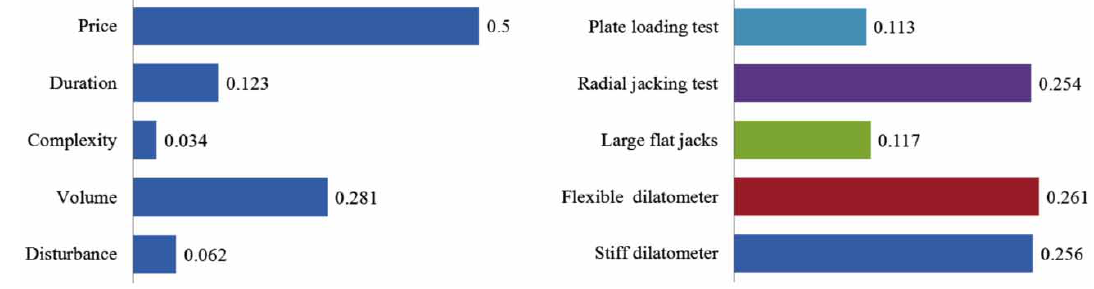
Fig. 8. Sensitivity analysis (cid:1) increasing the weight of the criterion Price to 50%